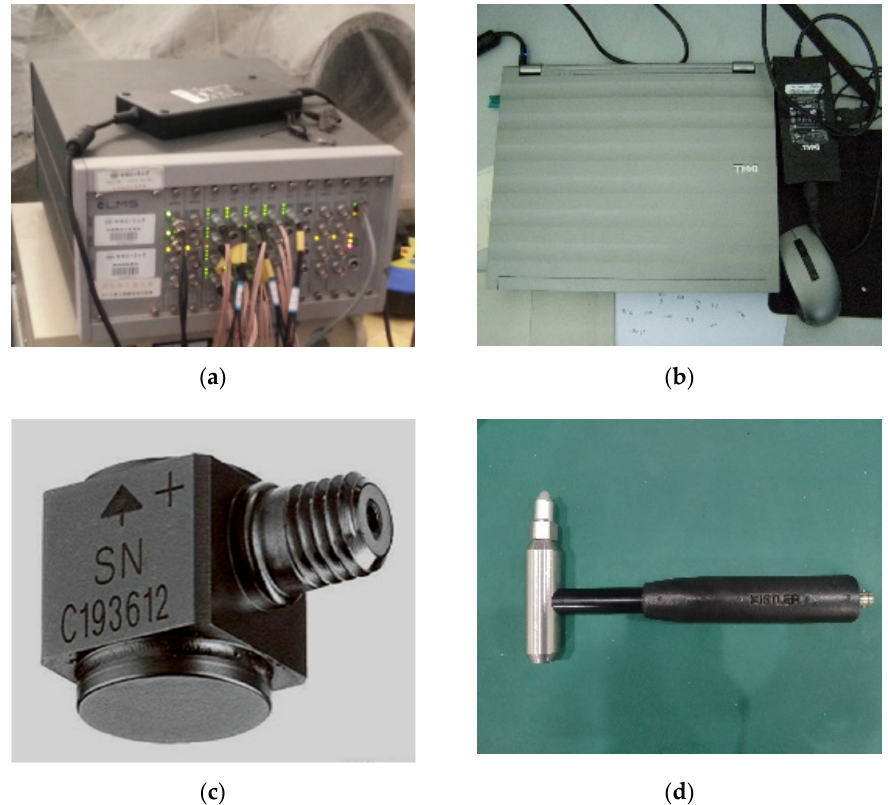
Figure 5. LMS modal testing and analysis equipment: ( a ) LMS data acquisition device; ( b ) LMS modal analysis system; ( c ) KISTLER acceleration sensor; ( d ) Force hammer.